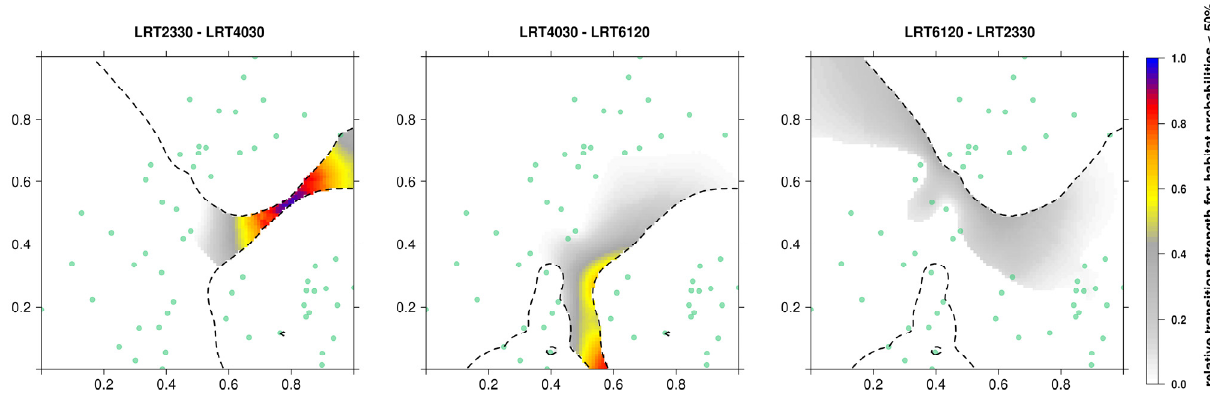
Figure 5. Relative strength of inter-habitat transition, as visualized by the arithmetic product of habitat-type probabilities below 50%. The color scale is min/max normalized over all transition